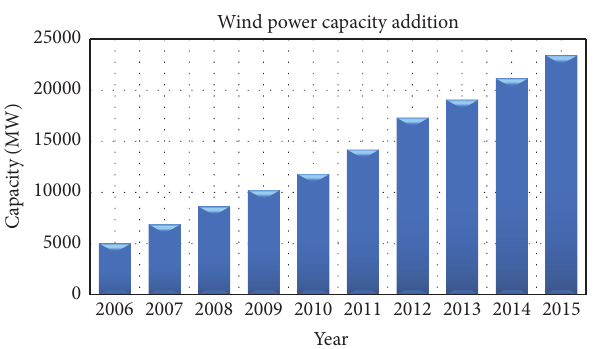
Figure 2: Cumulative and annual wind capacity additions,